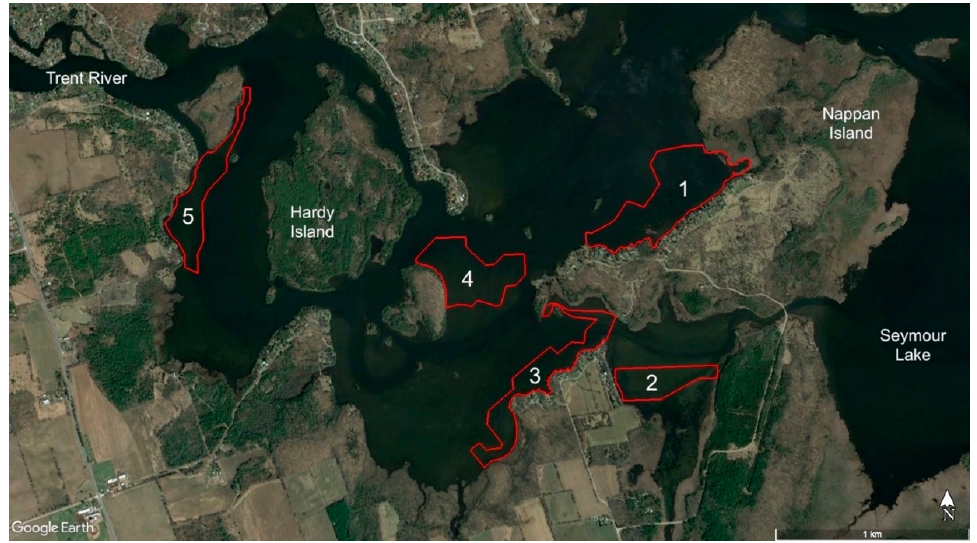
Figure 2. Overview of the study area in the Trent ‐ Severn Waterway, Ontario, Canada, showing the five sites over which aerial imagery was collected with a